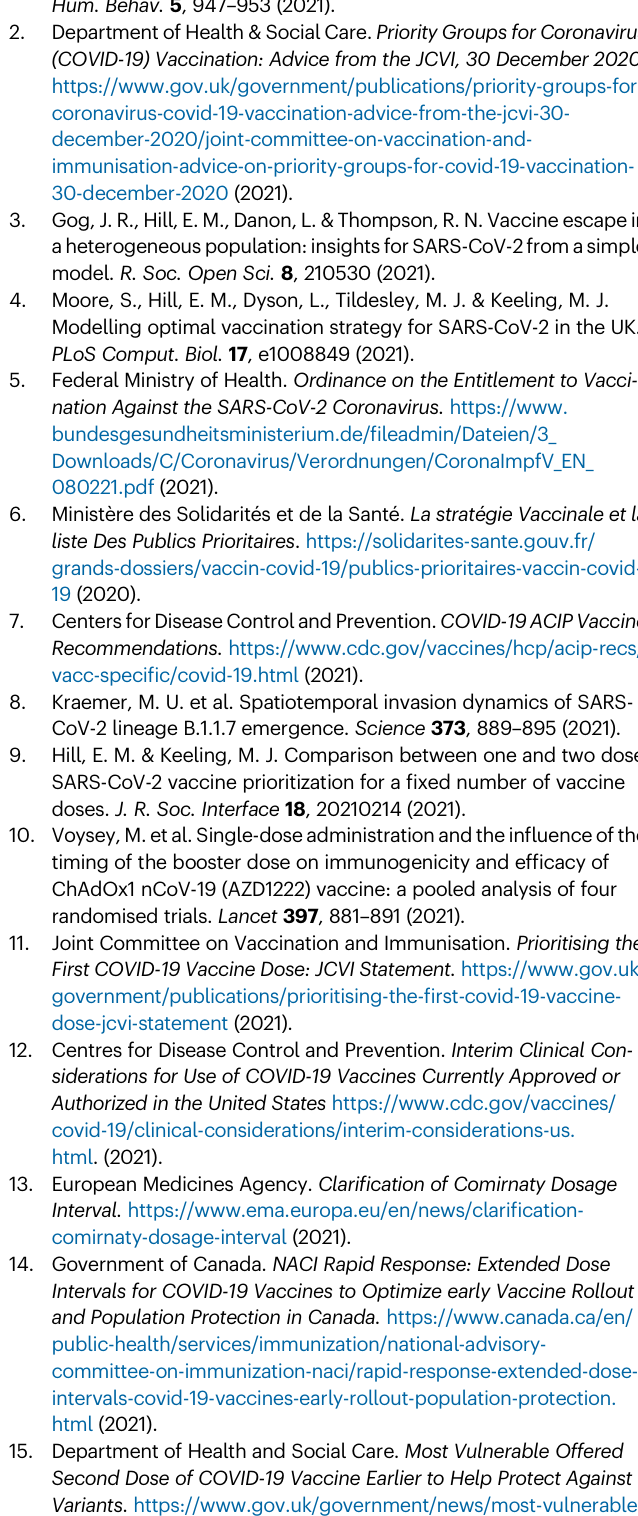
Table, 24 September 2021 .